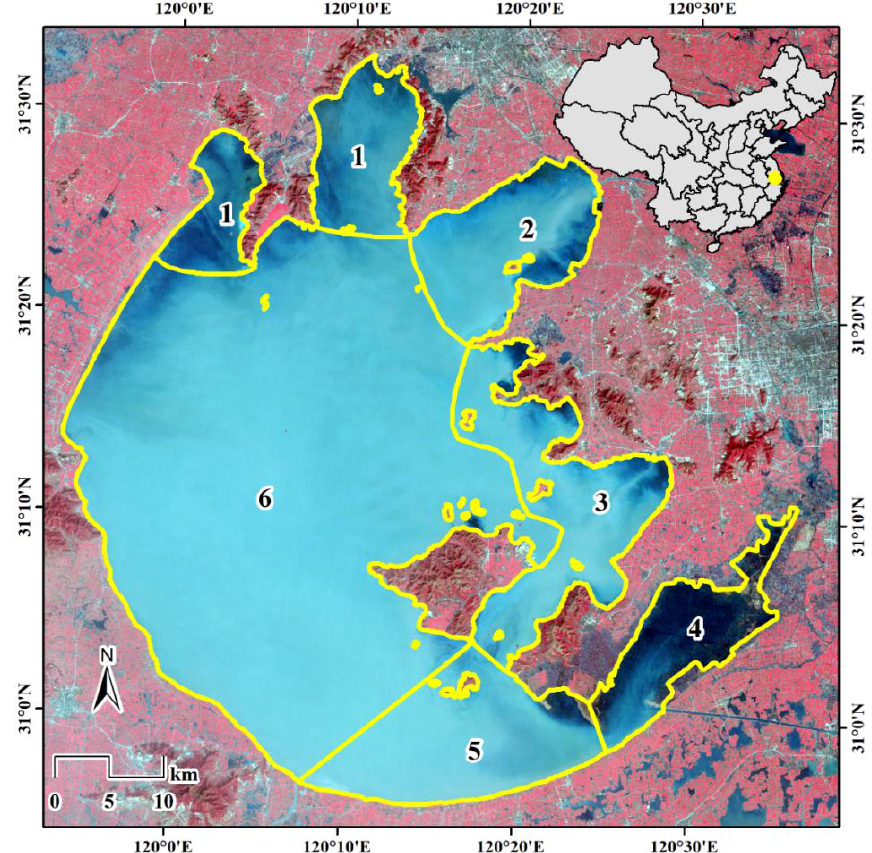
Figure 1. The Taihu Lake study area. The background image is a Landsat TM (Thematic Mapper) scene acquired on 1999-02-03 with standard false color composition (near-infrared band in red, red band in green, and green band in blue).